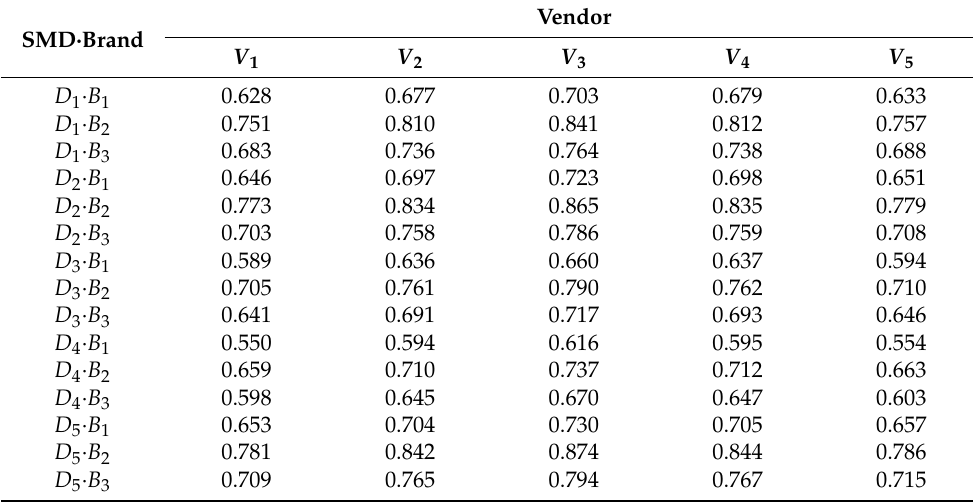
Table 9. The cumulative